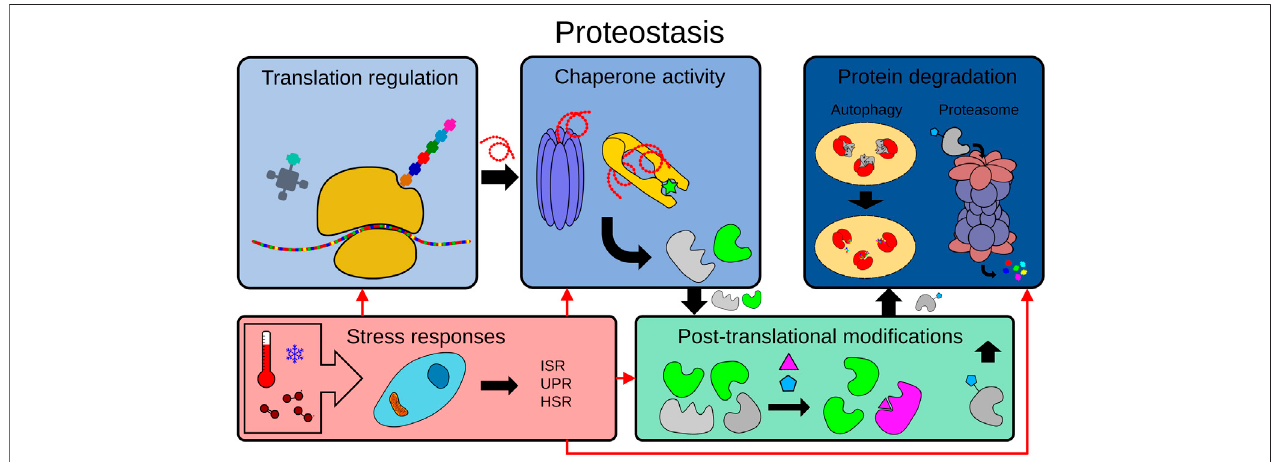
FIGURE 1 | The proteostasis network. To maintain proteome integrity, the proteostasis network is tightly regulated in healthy cells from translation to degradation. Theproteostasisnetworkincludesprotein translation,proteinfoldingbychaperones,post-translationalmodi fi cations(PTMs),proteindegradationmechanisms(e.g. the ubiquitin-proteasome system(UPS),the autophagy-lysosomepathway)and themodulationofadaptive stressresponsesbyphysiologicalorenvironmental signals (e.g. ISR: integrated stress response, UPR: unfolded protein response, HSR: heat shock